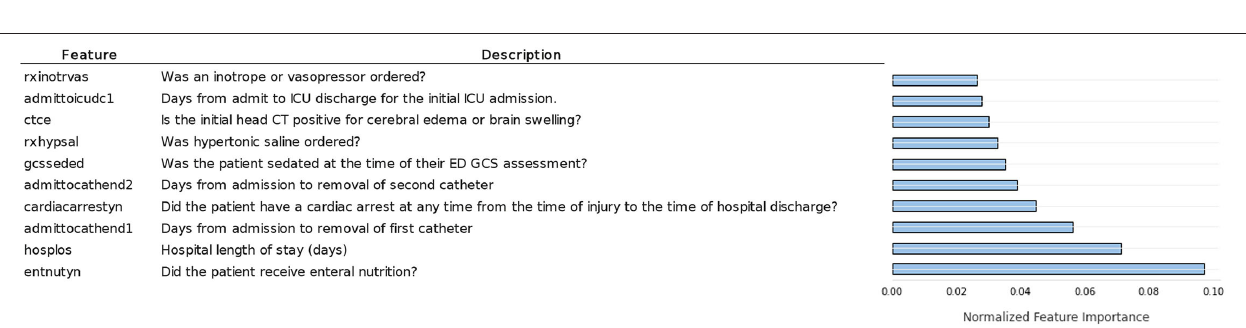
FIGURE 4 | Ten most important features according to normalized feature importance computed by Koerhsen’s feature selector tool, which uses a Gradient Boost